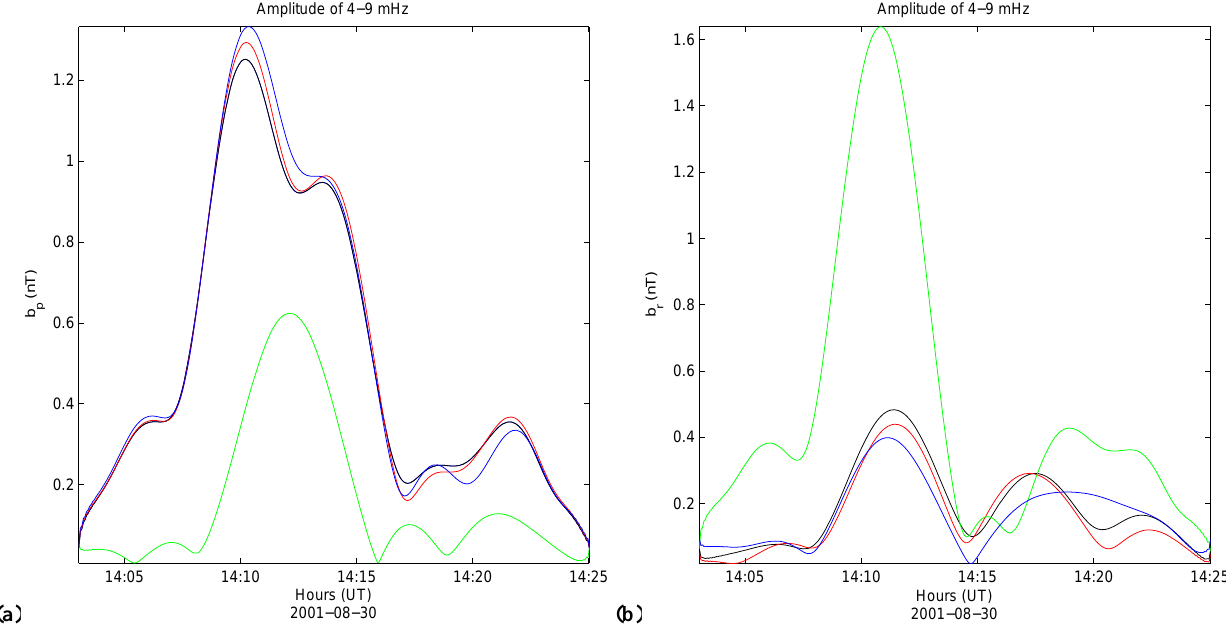
Fig. 9. Amplitude of the b p component (a) and the b r component (b) for the 6.8mHz wave.